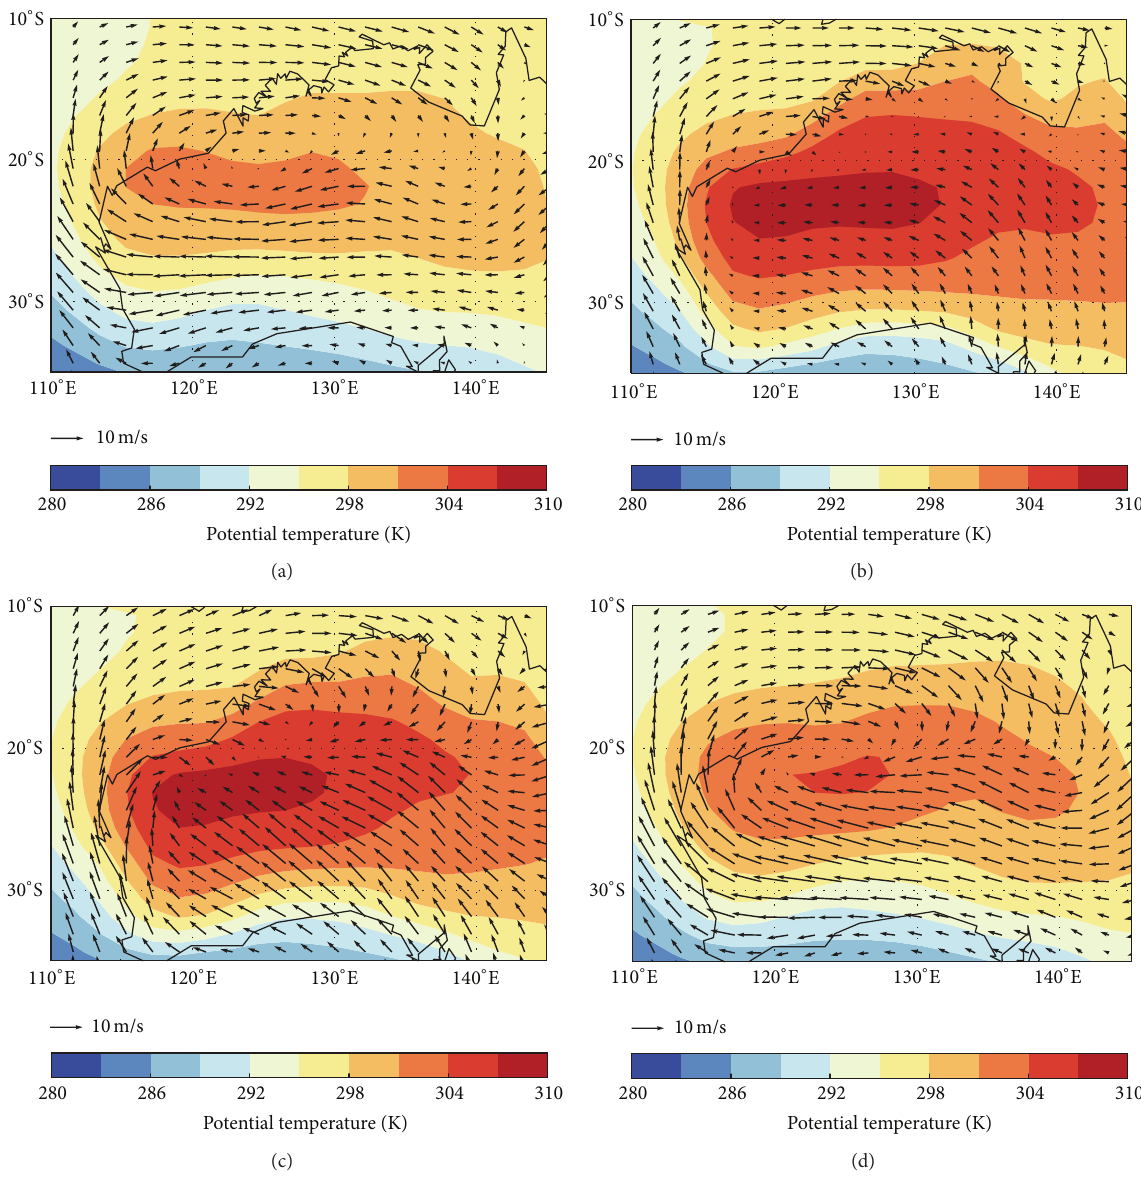
Figure 2: Climatological mean (1979–2001) potential temperature (K) at 925 hPa in A1.0 at (a) 0800 AWST, (b) 1400 AWST, (c) 2000 AWST, and (d) 0200